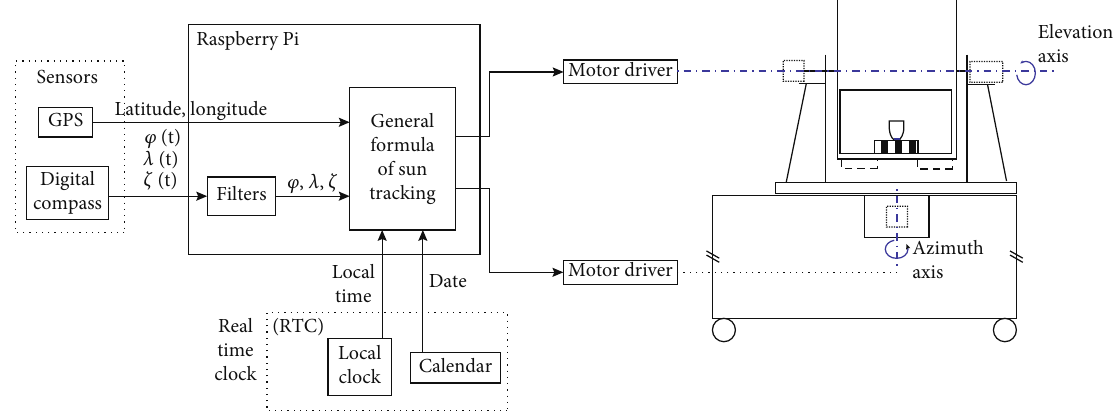
Figure 1: The architectural overview of prototype mobile sun-tracking (MST) system consisting of hardware and software